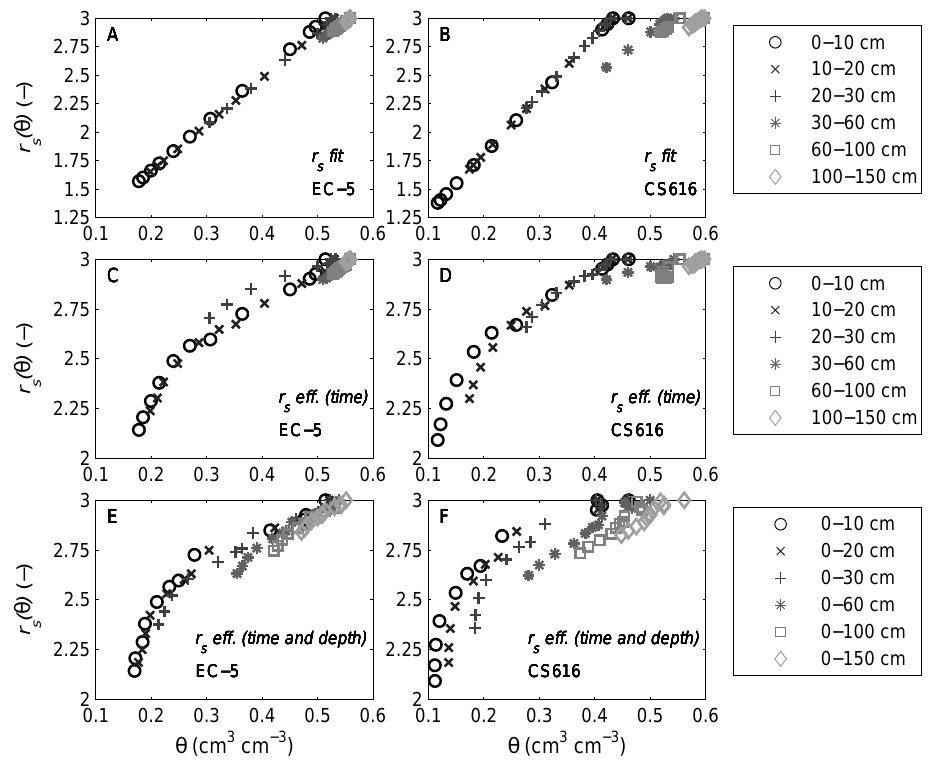
Fig. 6. Relationship between volumetric soil moisture content θ from EC-5 and CS616 and fitted r s in layer increments ( A and B ), effective r s over time in layer increments ( C and D ), and effective r s over time and depth of layers ( E and F